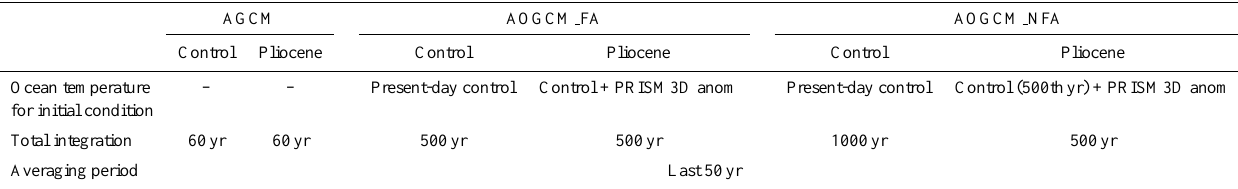
Table 2. Integration length, initial condition and period for analysis in each